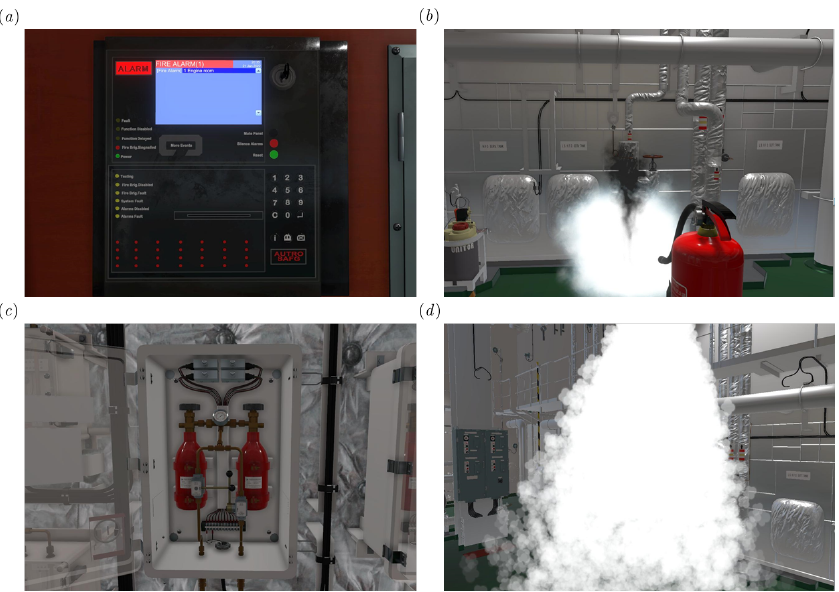
Figure 11. ( a ) The smoke detection panel issues an alarm; ( b ) the firefighter sprays CO 2 with the portable CO 2 fire extinguisher; ( c ) the gas cylinder of CO 2 automatic release equipment; ( d ) the CO 2 released by the fixed-CO 2 fire-extinguishing